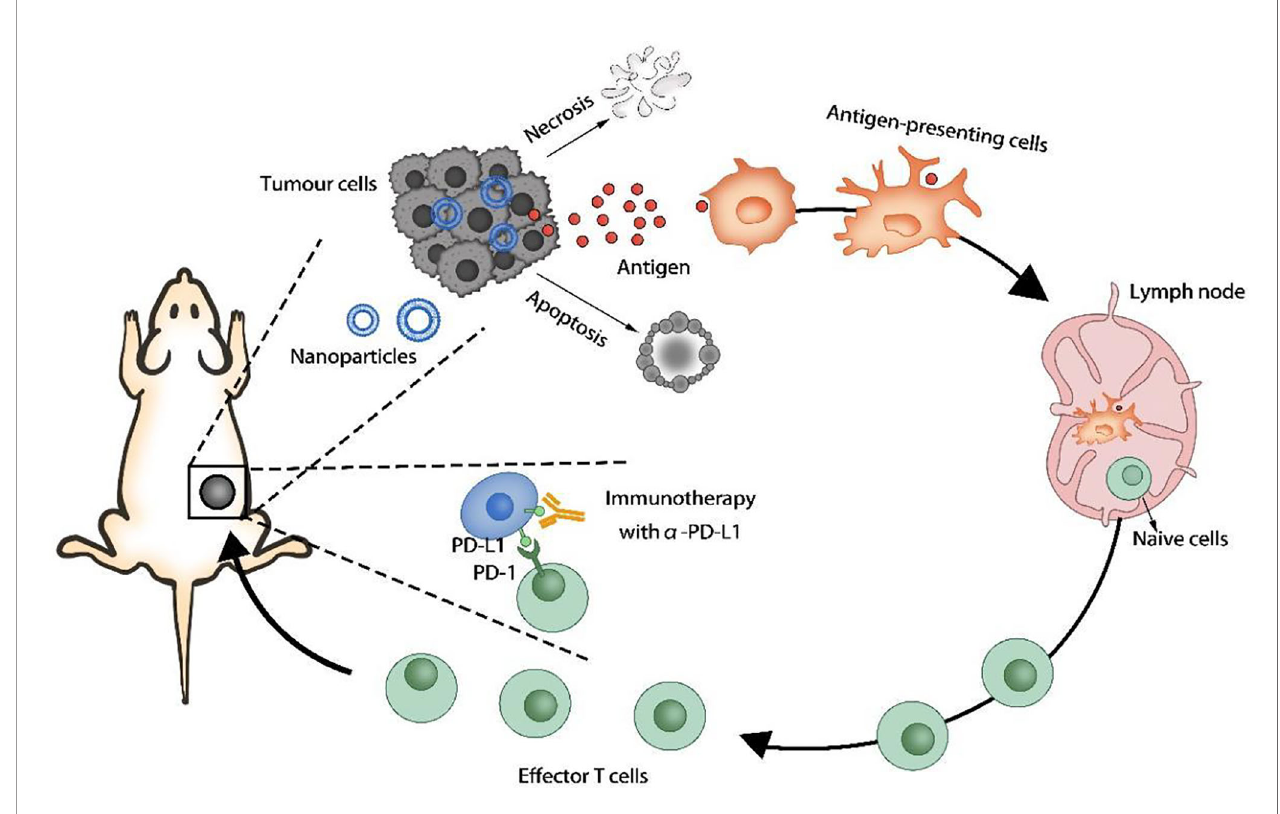
FIGURE 3 | Induction of immunogenic cell death (ICD).